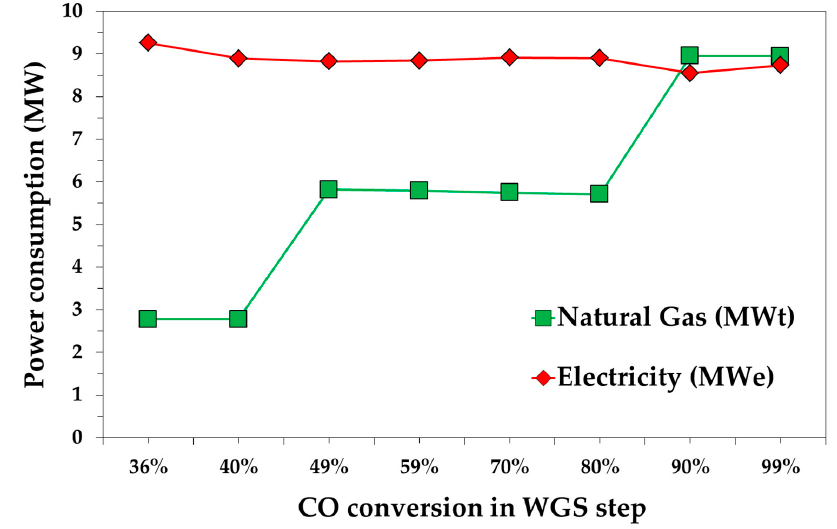
Figure 3. Natural gas and electricity required as function of CO conversion in the WGS step.